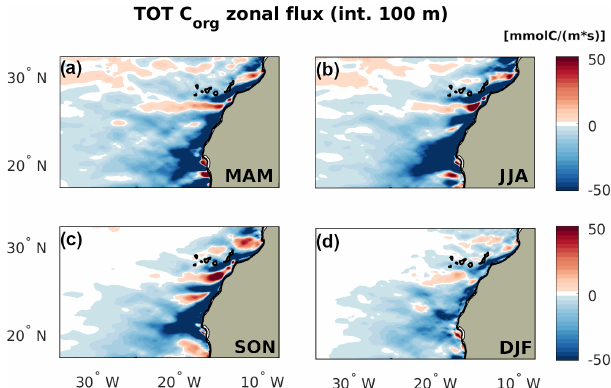
Figure 2. Seasonality of the total zonal transport of C org by season, with positive indicating eastward. The flux is integrated over the top 100m depth. Subpanels: (a) spring (MAM), (b) summer (JJA), (c) fall (SON), and (d) winter